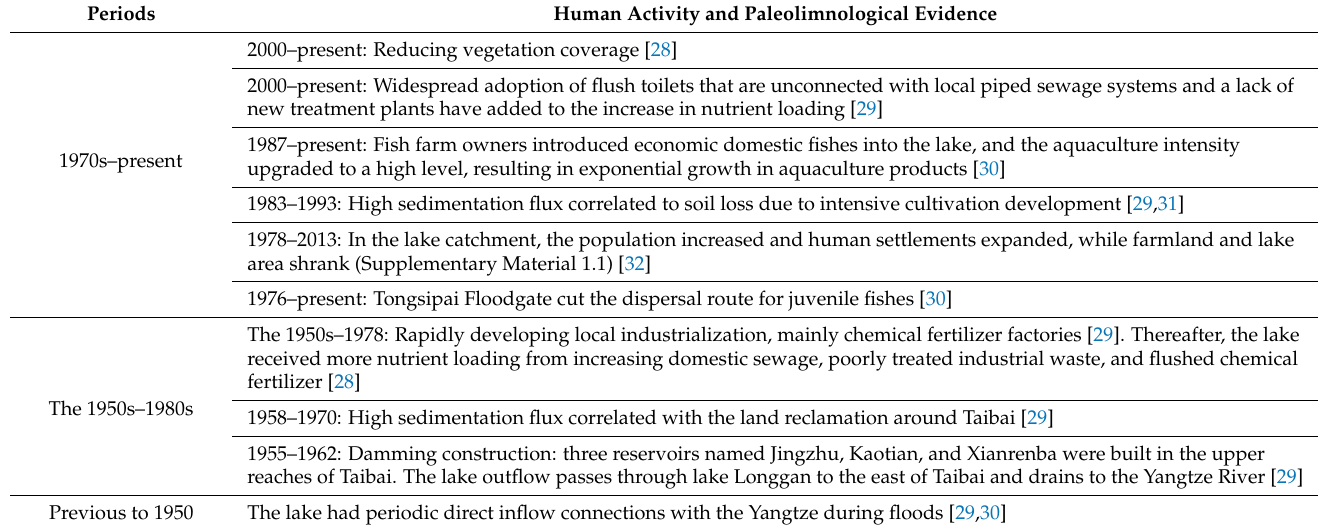
Table 1. Human activities in Taibai during the last